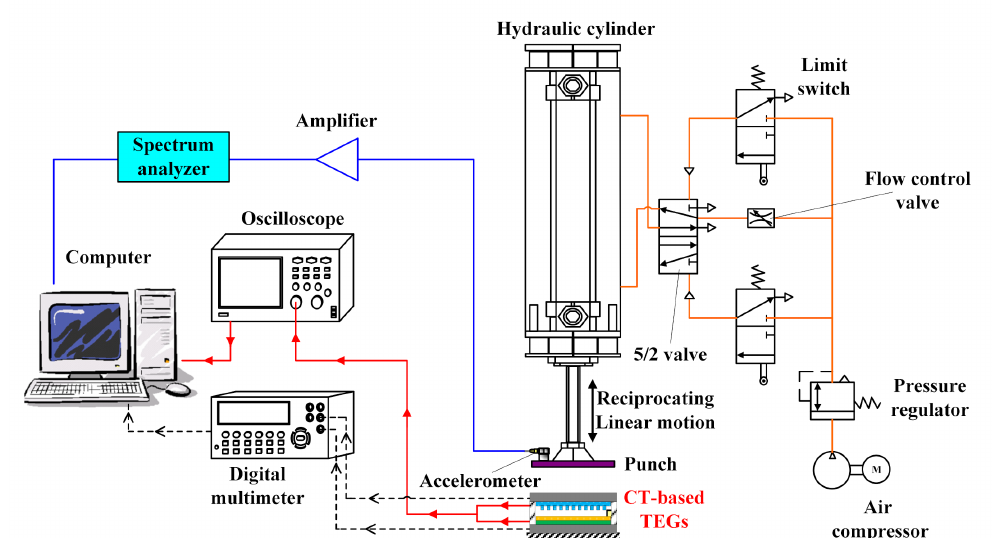
Figure 2. Schematic diagram of a reciprocating linear motion platform with a pneumatic cylinder for testing conductive textile (CT)-based TEG